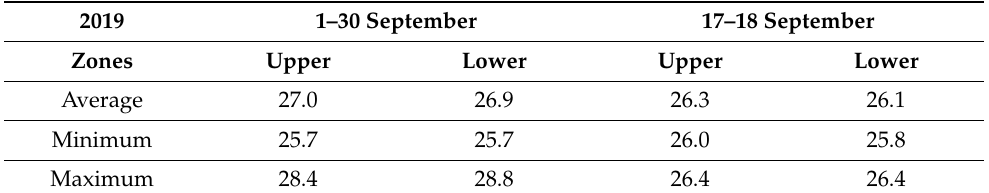
Table 2. Average monthly ambient temperature EMS values in the upper and lower main nave zones of Santos Juanes church in September 2019 compared with average values of two characteristic days selected for the 3D-TCV test.